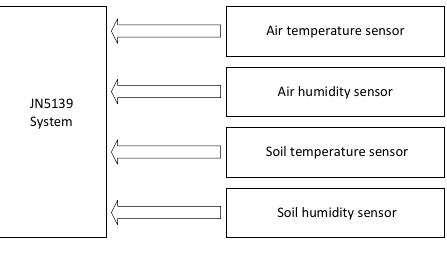
Figure 2. Sensor nodes structure.